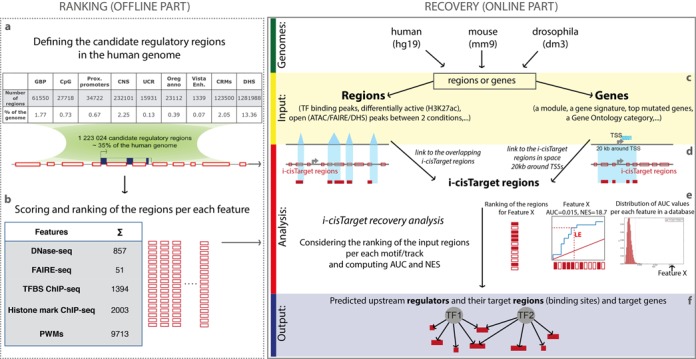
i-cisTarget workflow. The i-cisTarget web-tool consists of two parts, namely the ranking (offline part) and recovery (online part). (a) A set of 1,223,024 candidate regulatory regions (CRRs) is defined based on publicly available regulatory data, representing 35% of the human genome. (b) The collection of CRRs is scored and ranked according to different features, including motifs, TF and histone ChIP-seq, DNase-seq and FAIRE-seq, resulting in large ranking databases. (c) The online part starts with user input, which can be a set of genomic regions or a set of genes for human, mouse or fly. (d) The input set is mapped to the candidate i-cisTarget regions. In the case of regions/peaks, the overlapping CRRs (minimum overlap percentage is a parameter) with the peaks are considered in the analysis. When a gene set is used as input, then CRRs overlapping the entire space of X kb around TSSs are taken into the analysis (the default space for human and mouse genome is 20 kb around TSS; the default for fly is 5 kb upstream of TSS and all introns). (e) The recovery analysis identifies the feature for which the input CRRs are most enriched in the top of the CRR ranking of that feature. This enrichment is calculated by the Area Under the recover Curve (AUC) and all features with normalized AUC (i.e. Normalized Enrichment Score, or NES) above 3.0 are returned. (f) For each enriched feature and upstream regulator the direct target regions are provided, with a link to a BED file for download and a track in the UCSC Genome Browser.